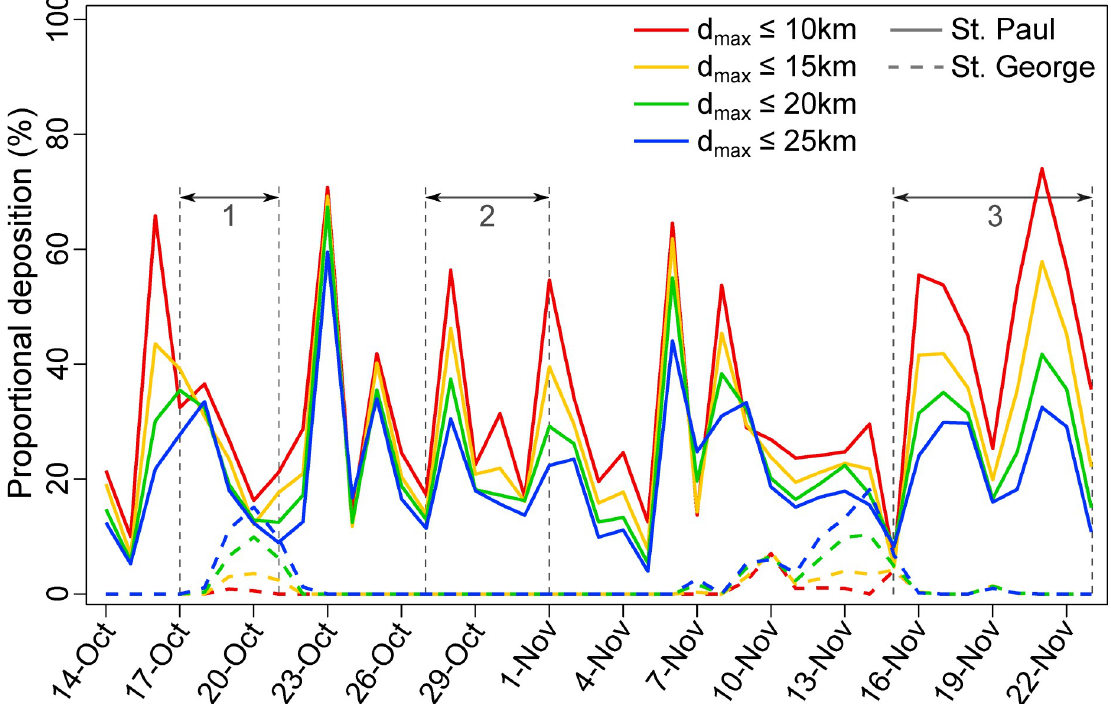
Fig 6. Time-series of simulated deposition (assuming constant mortality per day and median carcass float duration of 7 days) on St. Paul (solid lines) and St. George (dashed lines) Islands, Alaska. Results are shown for four alternate distributions of moribund birds: birds distributed uniformly from St. Paul to 10 km, 15km, 20km and 25 km offshore. Time periods in which deposition was observed on St. Paul are bounded by numbered (1–3 for each deposition window) vertical gray dashed lines.